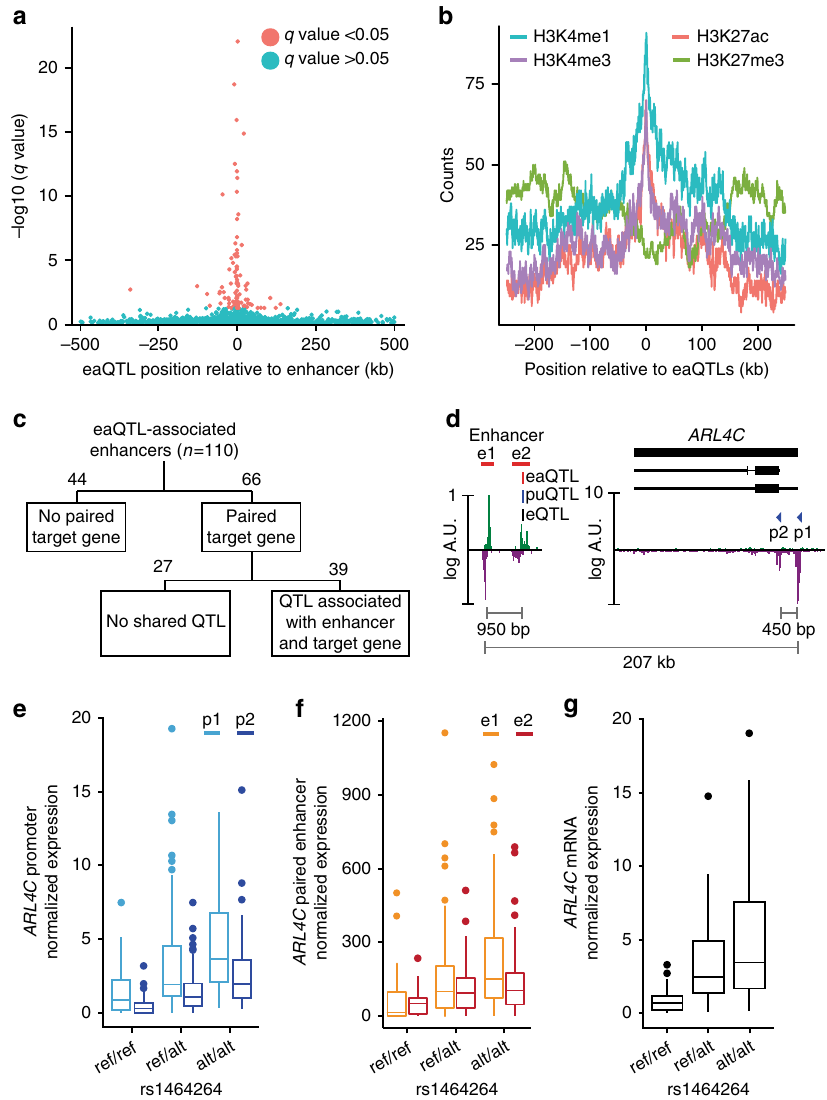
Fig. 4 eaQTLs mapping and integration with puQTLs and eQTLs. a Signi fi cance relative to distance for each enhancer best-associated eaQTL plotted for a 1 Mb window. b Total counts of histone marks ChIP-seq signals (GM12878 cells, ENCODE data) for the 500 kb regions fl anking eaQTLs. c Schematic representation of the procedure to identify triplets of regulatory variants, enhancers, and paired promoters. d CAGE signal at the ARL4C locus and associated enhancer region. The variant (rs1464264) mapped as a puQTL for ARL4C -associated CAGE peaks (p1, p2) and eaQTL for paired enhancers (e1, e2) is shown. Normalized promoter ( e ), enhancer ( f ), and mRNA ( g ) expression relative to each genotype group are plotted for the entire